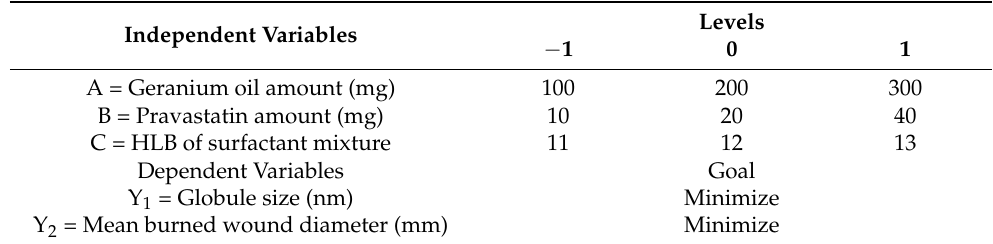
Table 1. Independent variables and their levels, along with dependent variables and their constraints, in the BBD of the nanoemulsion